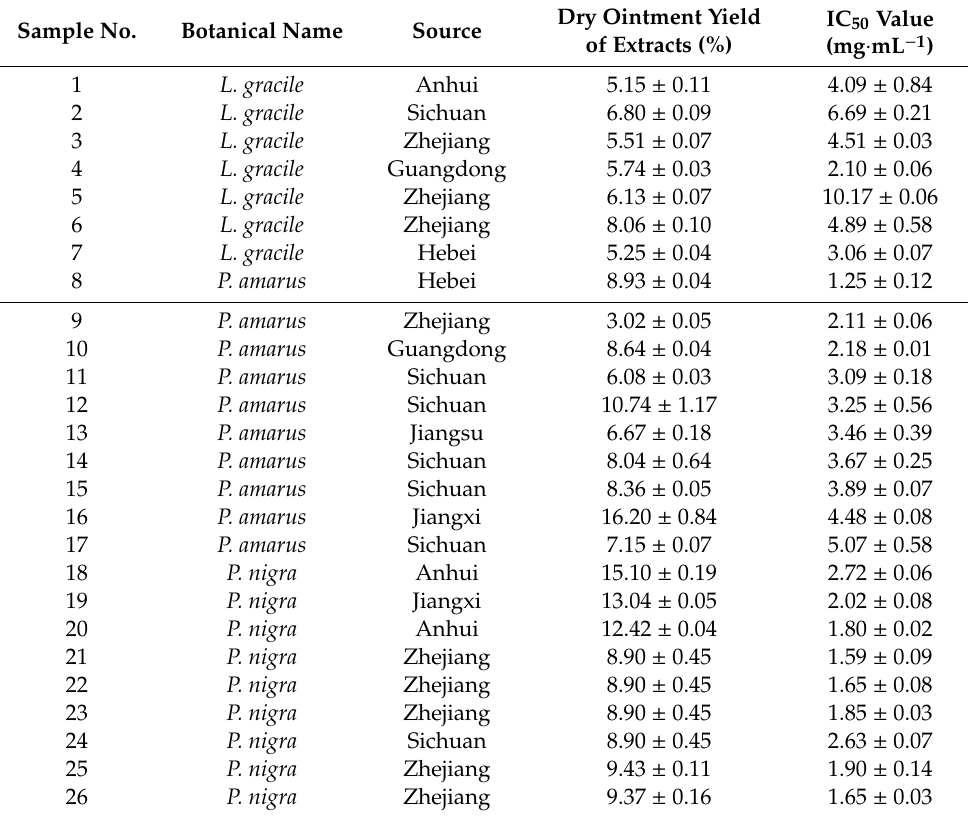
Table 4. The dry weight and antioxidant inhibitory concentration (IC) 50 values of 26 leaf extracts. Sample No.